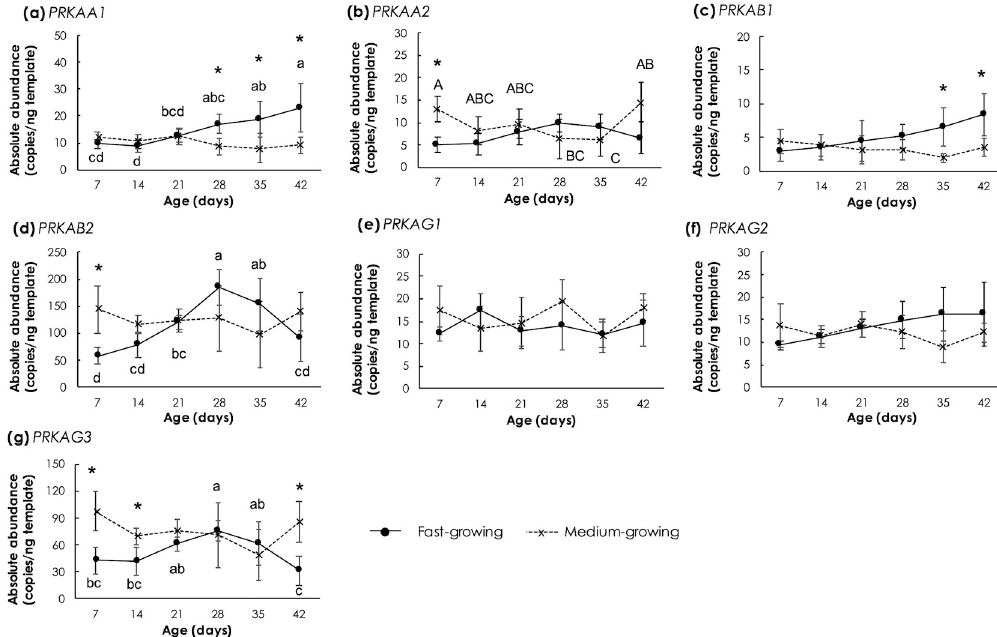
Fig 4. Absolute transcript abundance of genes encoding different isoforms of 5’-adenosine monophosphate-activated protein kinase (AMPK) in Pectoralis major muscle of fast- and medium-growing chickens at different ages. The AMPK isoforms include (a) α 1 isoform ( PRKAA1 ), (b) α 2 isoform ( PRKAA2 ), (c) β 1 isoform ( PRKAB1 ), (d) β 2 ( PRKAB2 ), (e) γ 1 isoform ( PRKAG1 ), (f) γ 2 isoform ( PRKAG2 ), and (g) γ 3 isoform ( PRKAG3 ). Markers and error bars depict mean and standard deviation (n = 5). Lower case letters indicate significant differences among fast-growing chickens. Upper case letters indicate significant differences among medium-growing chickens. Asterisks indicate significant differences between the two strains at the same age. � p < 0.05, �� p <